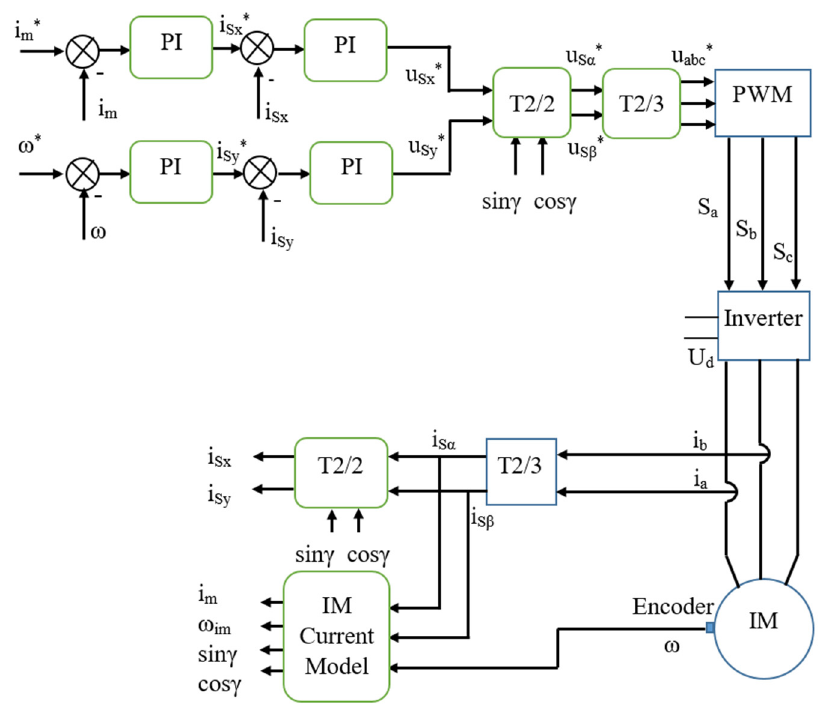
Figure 2. Block diagram of IMD with the FOC strategy (the symbol * means reference values).